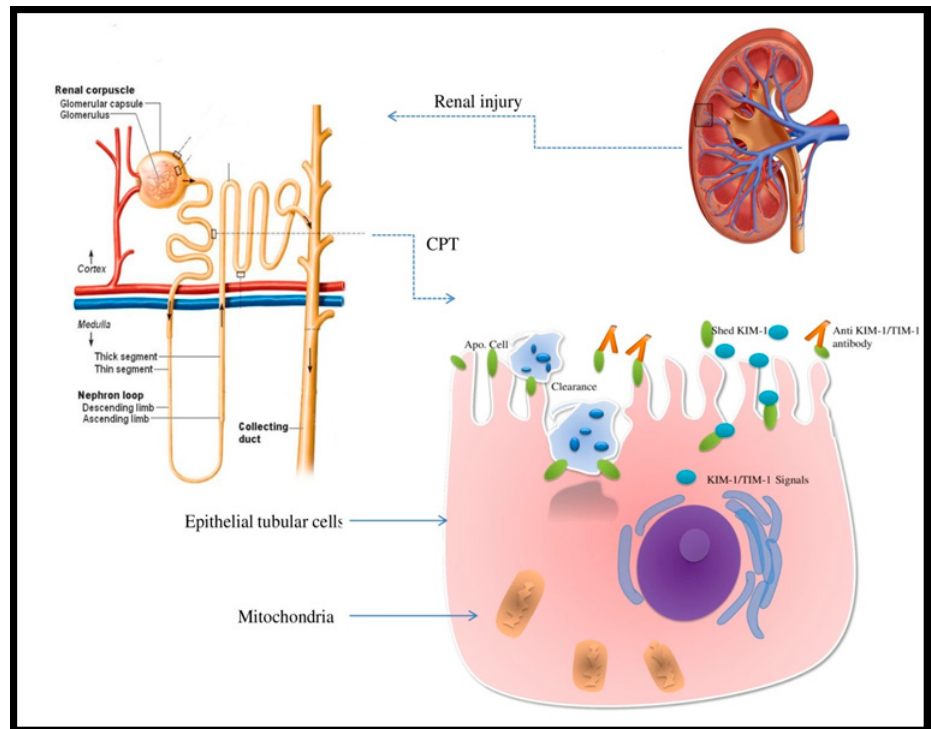
Figure 2. Kidney injury molecule-1 (KIM-1) / T cell immunoglobulin mucin-1 (TIM-1) expression in the proximal convoluted tubule (CPT) after renal injury phagocyting apoptotic cells. The extracellular domain is shed and the phosphatidylserine receptor enhances apoptotic bodies and necrotic debris phagocytosis .